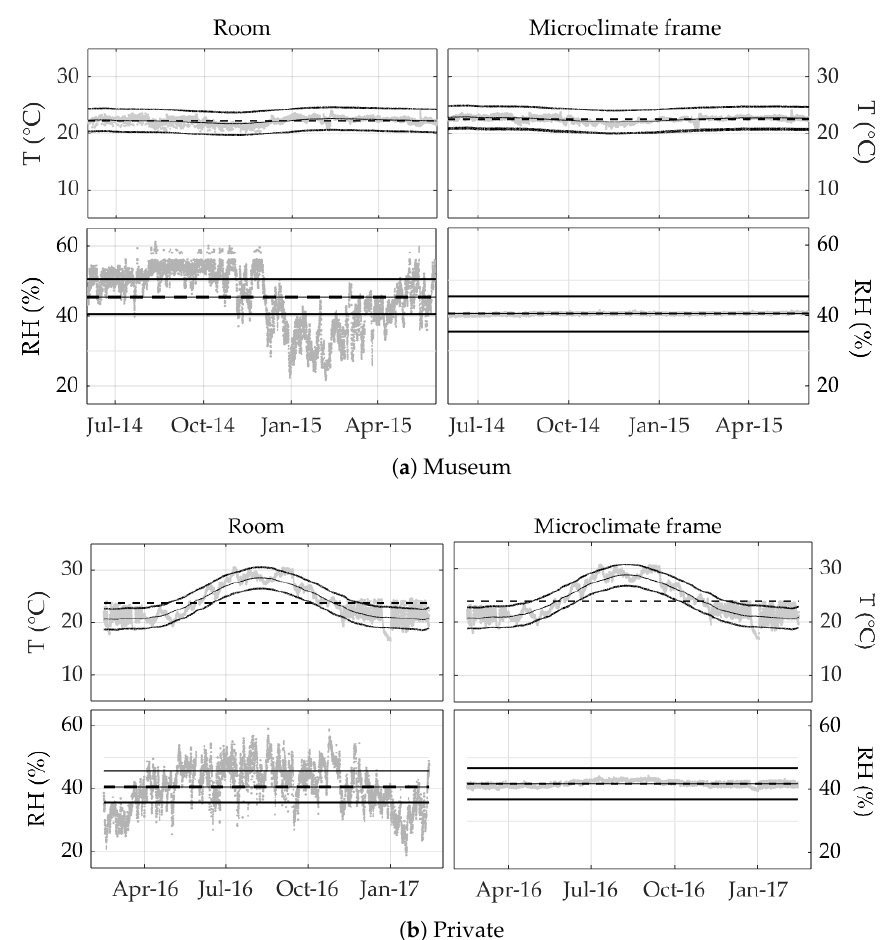
Figure 4. Temperature and relative humidity the bands of tolerance for ASHRAE Class AA (thick lines) together with the values measured in Museum ( a ) and Private ( b ) during a year (grey points). The thin lines indicate the seasonal moving average, the dashed lines the annual mean of the measured